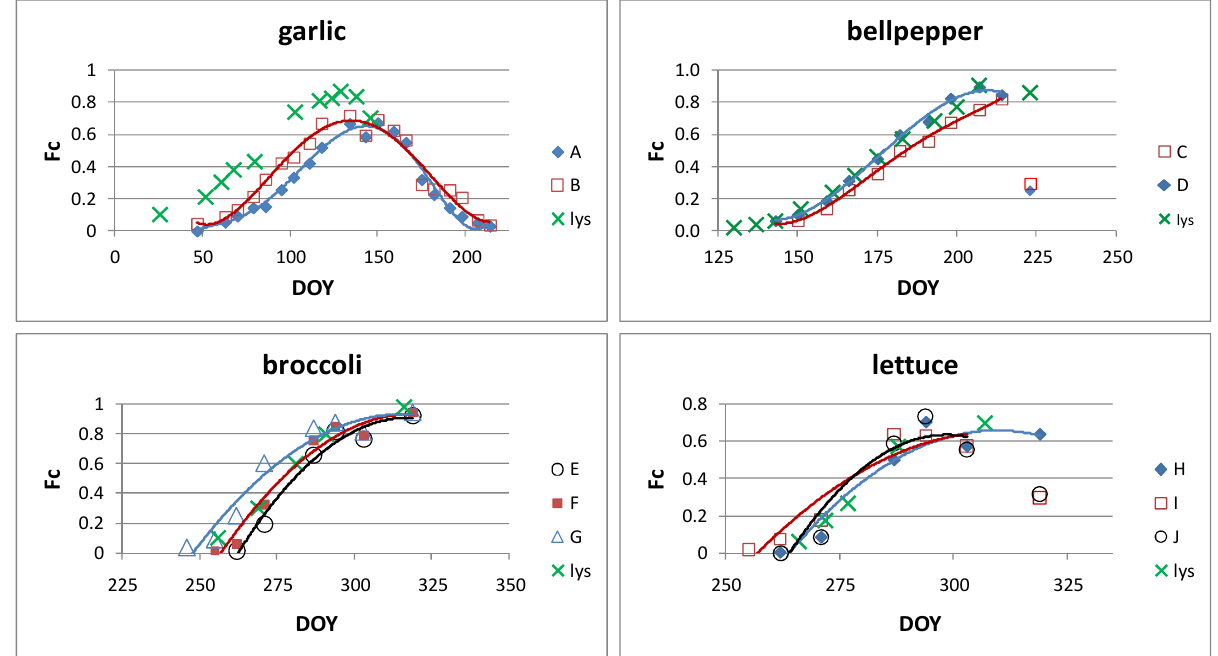
Figure 6. Landsat time-series of mean Fc beginning at apparent start of development stage for four different crops, with trendlines. Letters represent fields of Table 2. Observed profiles for fields E, F, G, and H terminate prior to harvest due to cloud cover past DOY 319. Full growth cycle captured for the other fields. The trendlines exclude the final plotted datapoints for fields C, D, I, and J, which represent apparent post-harvest conditions and are shown for reference only. Fc measurements obtained during respective lysimeter experiments [15] also shown for